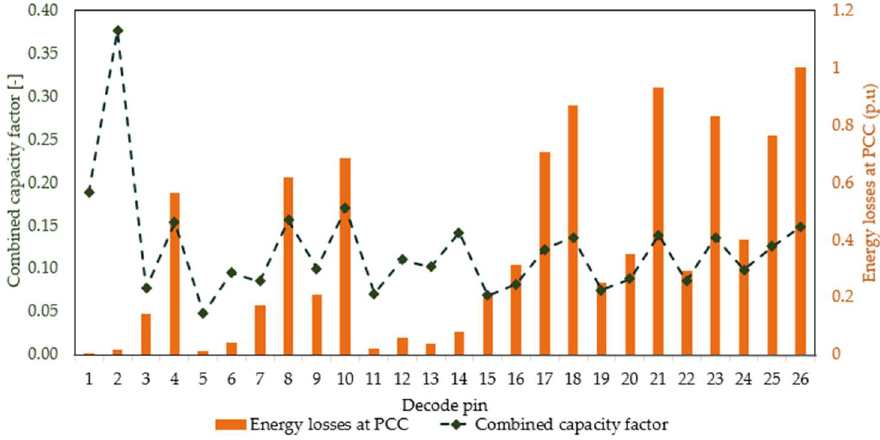
Figure 9. Energy losses versus capacity factor .